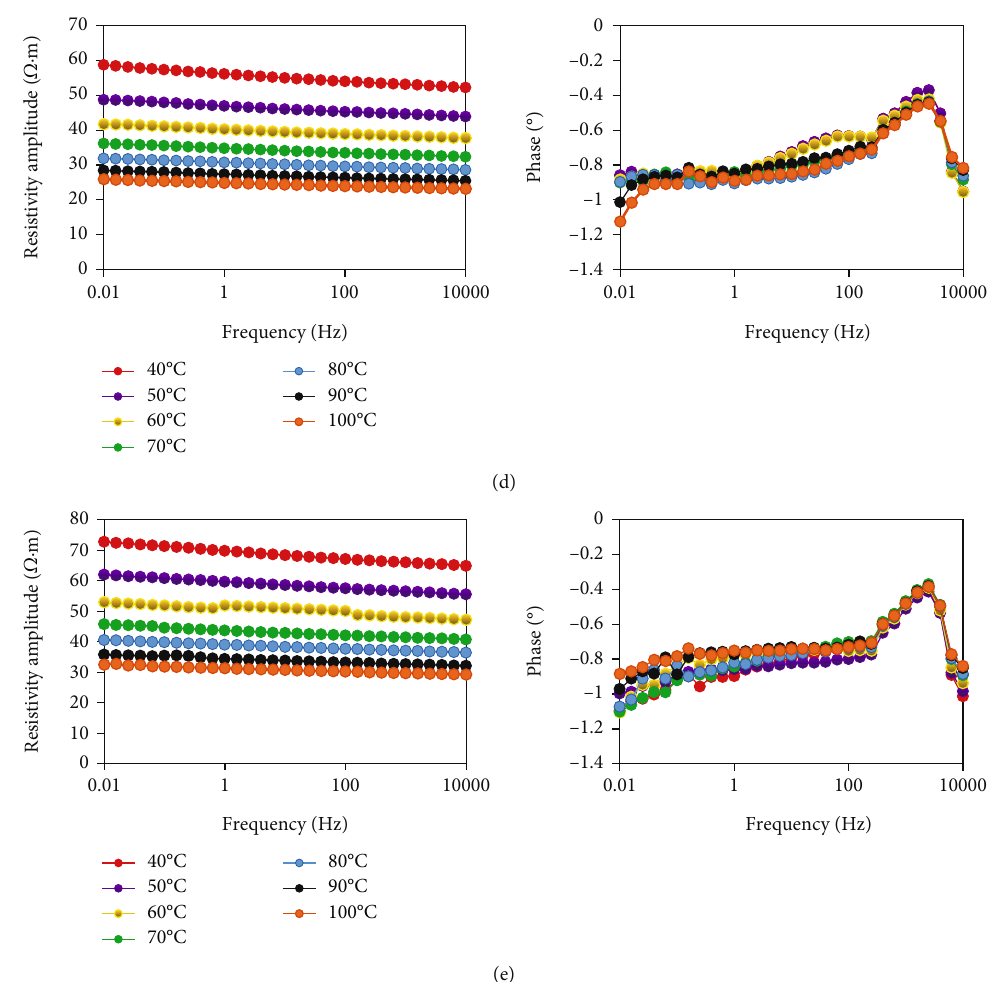
Figure 6: (a – e) The amplitude and phase curves of the complex resistivities of samples 1, 2, 3, 4, and 5 under variable temperature conditions, respectively. The left column shows the complex resistivity amplitude curves, and the right column shows the complex resistivity phase